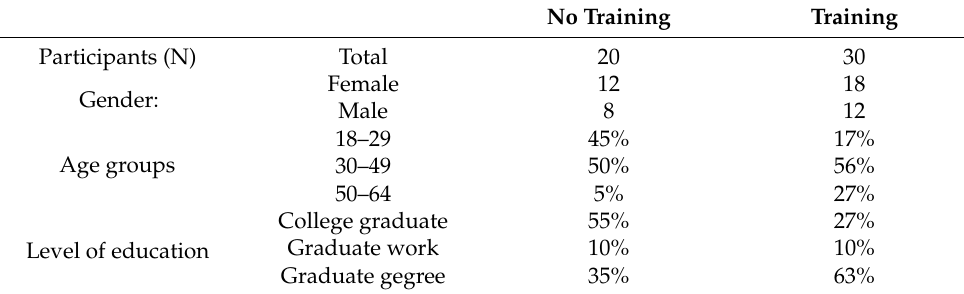
Table 2. Study participant